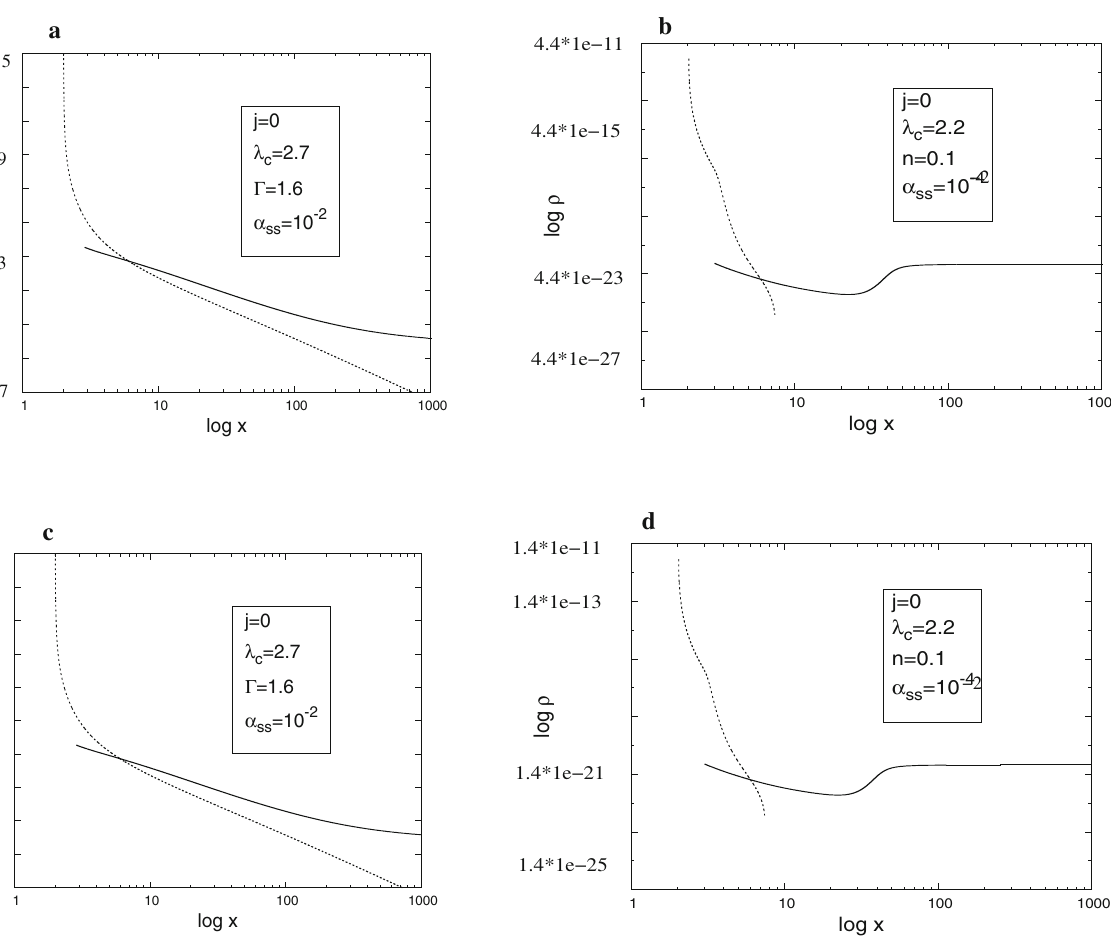
Fig. 4 a , c Plotsof log (ρ) vs log ( x ) fornonviscous accretiondiscflow around a non-rotating BH for adiabatic case using NFW and Einasto profile respevctively. b , d Plots of log (ρ) vs log ( x ) for viscous accre-